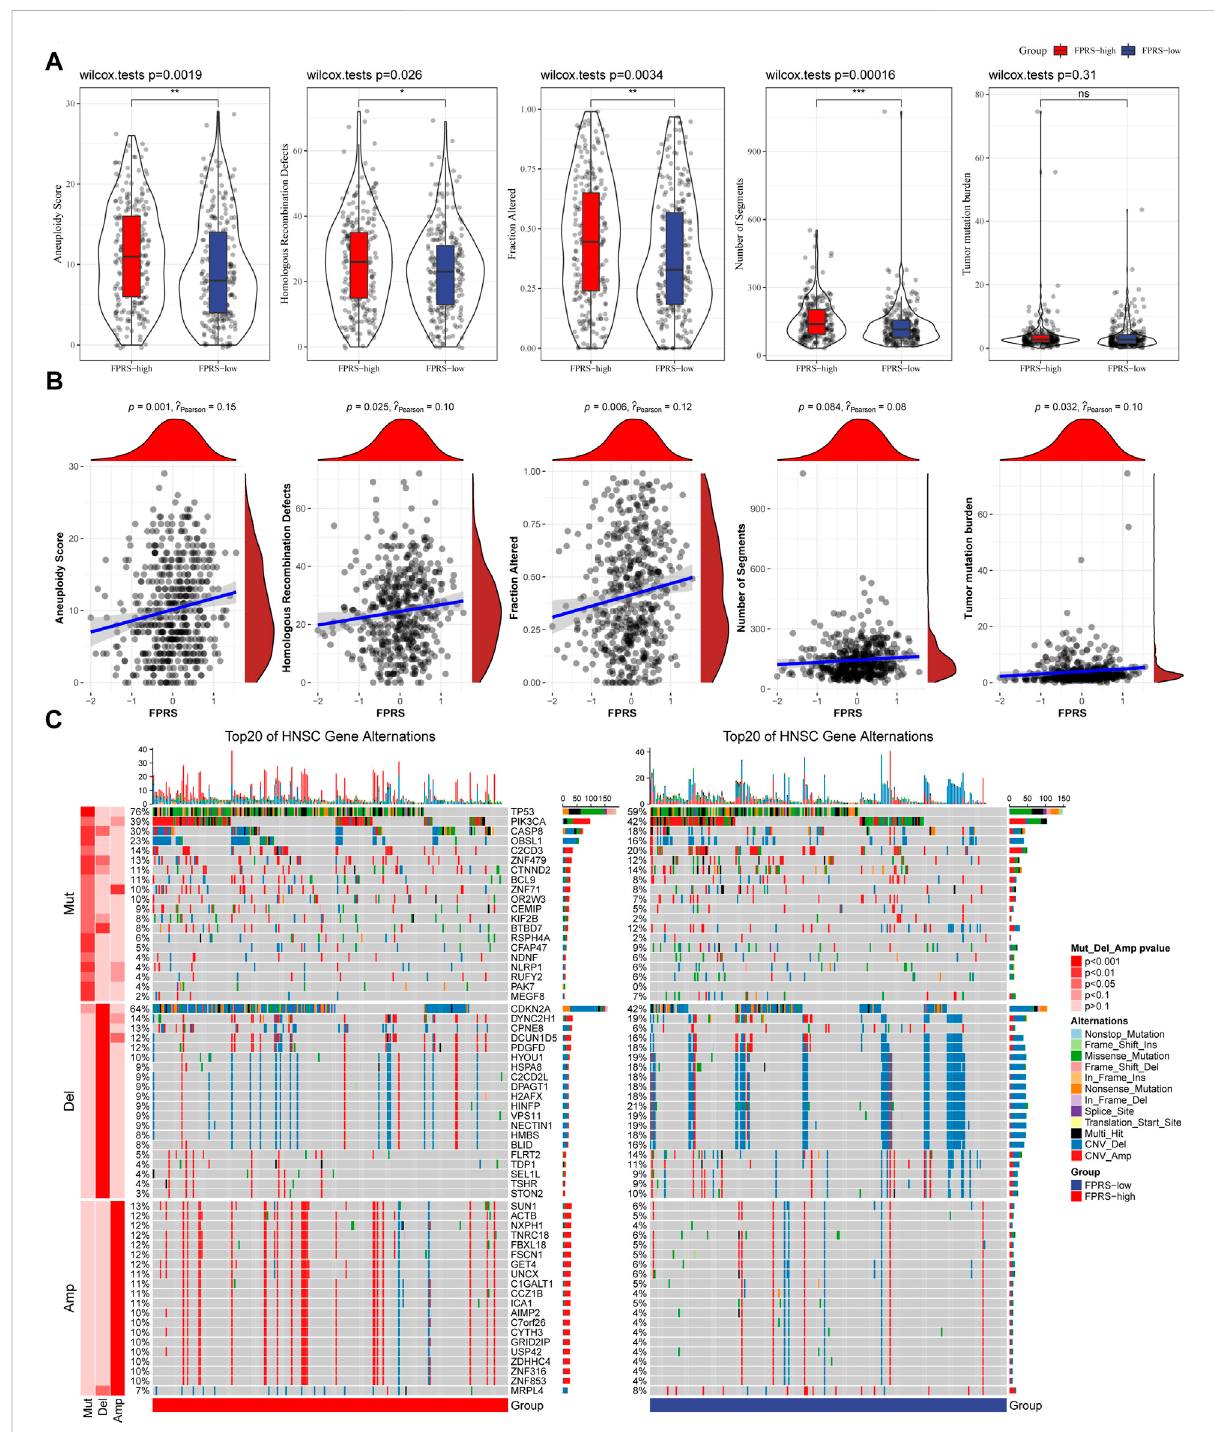
FIGURE 8 Differences inFPRS groupings of the TCGA cohort. (A) Compare the differences in Homologous Recombination Defects, Aneuploidy Score, Fraction Altered, Number of Segments and Tumor mutation burden in different FPRS groups of the TCGA cohort; (B) FPRS and Homologous Recombination Defects, Aneuploidy Score, Fraction Altered, Number of Segments and Tumor mutation Correlation between burden; (C) Somatic mutationandcopynumbervariationanalysis(Fishertest)ofFPRSgroupingsintheTCGAcohort.* p < 0.05;** p < 0.01;*** p < 0.001;and**** p <